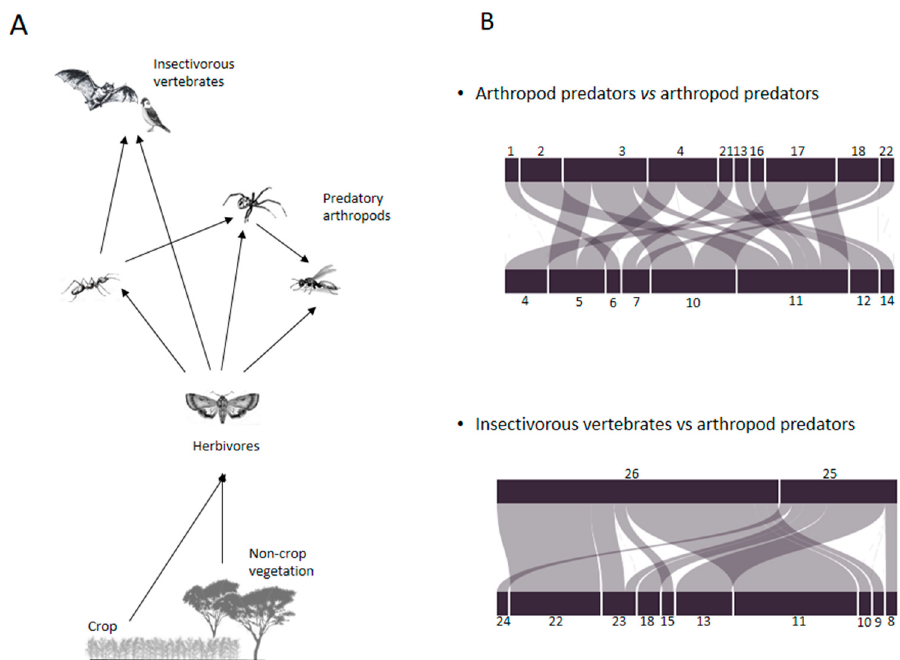
Figure 4. ( A ) Qualitative trophic networks of arthropod and vertebrate predators collected from a millet-based agroecosystem in Senegal. Arrows represent biomass flow between predators and preys. ( B ) Intraguild interactions. Arthropod predators: 1: Araneae sp.1. 2: Araneae sp.2. 3: Araneae sp.3. 4: Bradybeanus scalaris . 5: Camponotus sp. 6: Carabidae sp. 7: Carbula curtana . 8: Carbula sp. 9: Chrysoperla sp. 10: Creontiades pacificus . 11. Creontiades pallidus . 12: Encyrtidae sp. 13: Forficula senegalensis . 14: Gnaphosidae sp. 15: Mallada signatus . 16: Monomorium sp. 17. Orius maxidentex . 18: Pachycondyla sp. 19: Philonthus discoideus . 20: Plesiochrysa atalotis . Parasitoids of arthropods: 21: Cylindromyia bicolor . 22: Pegoplata nigroscutellata . 23: Perilampus sp. 24: Pristomerus pallidus . Insectivorous vertebrates: 25: Ploceus cucullatus . 26: Taphozous mauritianus .